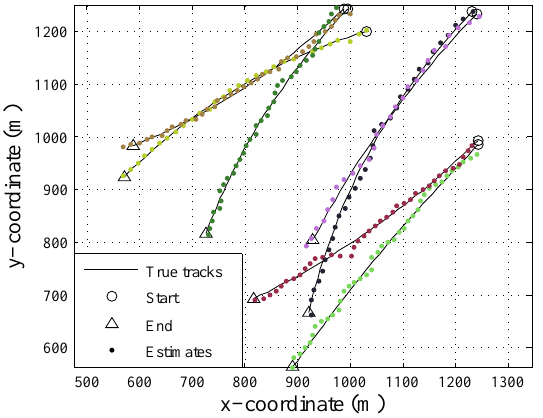
Figure 7. The true and estimated trajectory of a S-LMB-GOM filter.